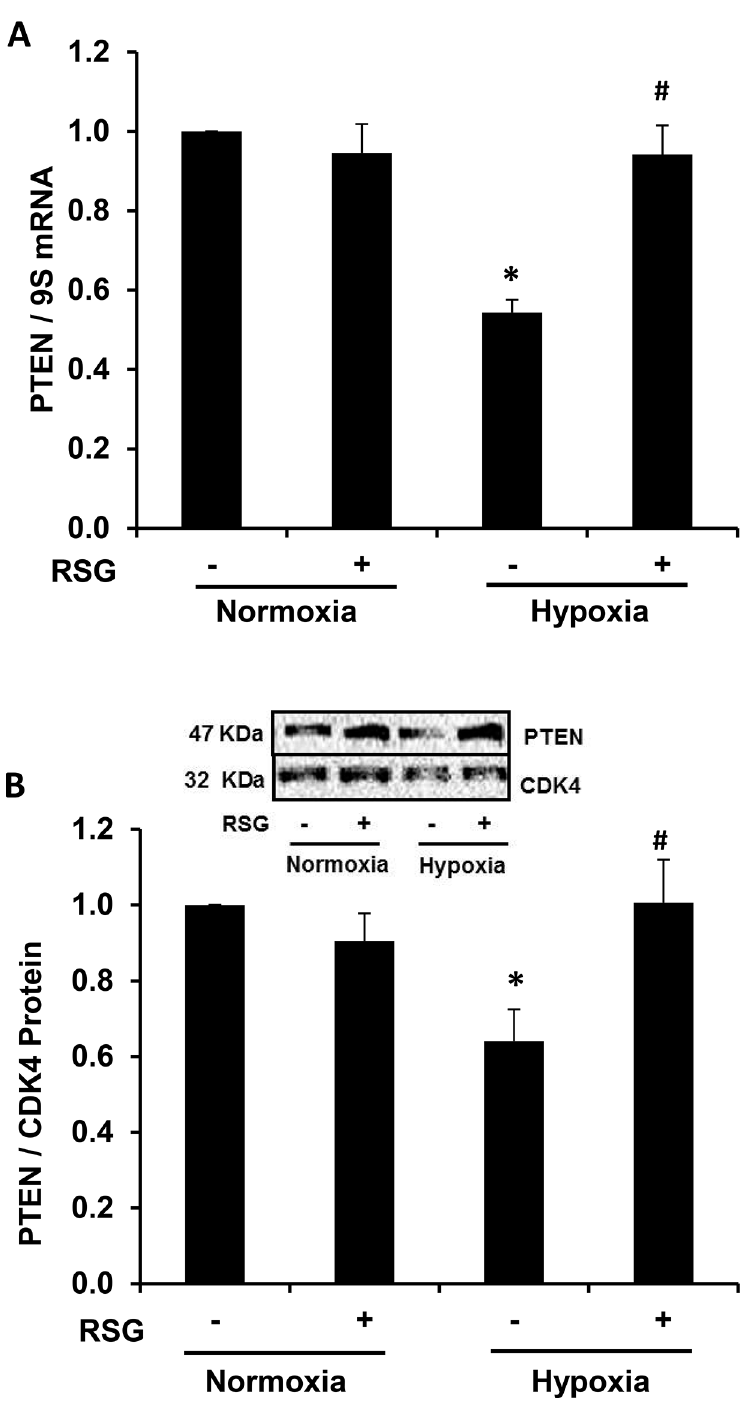
Fig 1. Rosiglitazone attenuates hypoxia-induced reductions in HPASMC PTEN expression. HPASMC were exposed to hypoxic conditions for 72 hours, and RSG was administered to selected monolayers during the last 24 hours of exposure. PTEN mRNA and protein levels were determined in all groups. A representative immunoblot is shown in panel B. Each bar represents mean ± SEM HPASMC PTEN (A) mRNA or (B) protein levels. * P < 0.01 vs Normoxia (-), # P < 0.01 vs Hypoxia (-) (n = 3 –